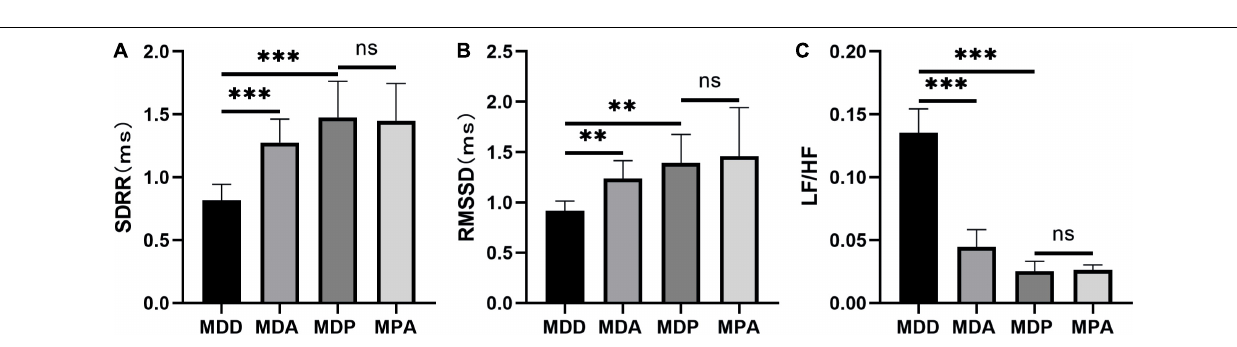
FIGURE 13 | Statistical analyses of HRV. (A) SDRR. (B) RMSSD. (C) LF/HF. n = 8 per group. ** p < 0.01, *** p < 0.001 vs. MDD; ns, no